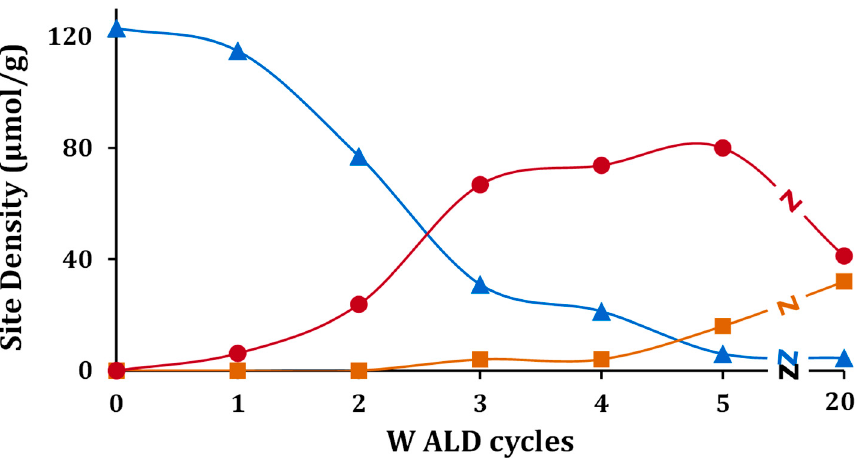
Figure 7. Reaction site densities of ( ▲ ) dehydrogenation sites, ( ● ) Brønsted sites, and ( ■ ) oxidation sites as a function of the number of WO x ALD cycles.